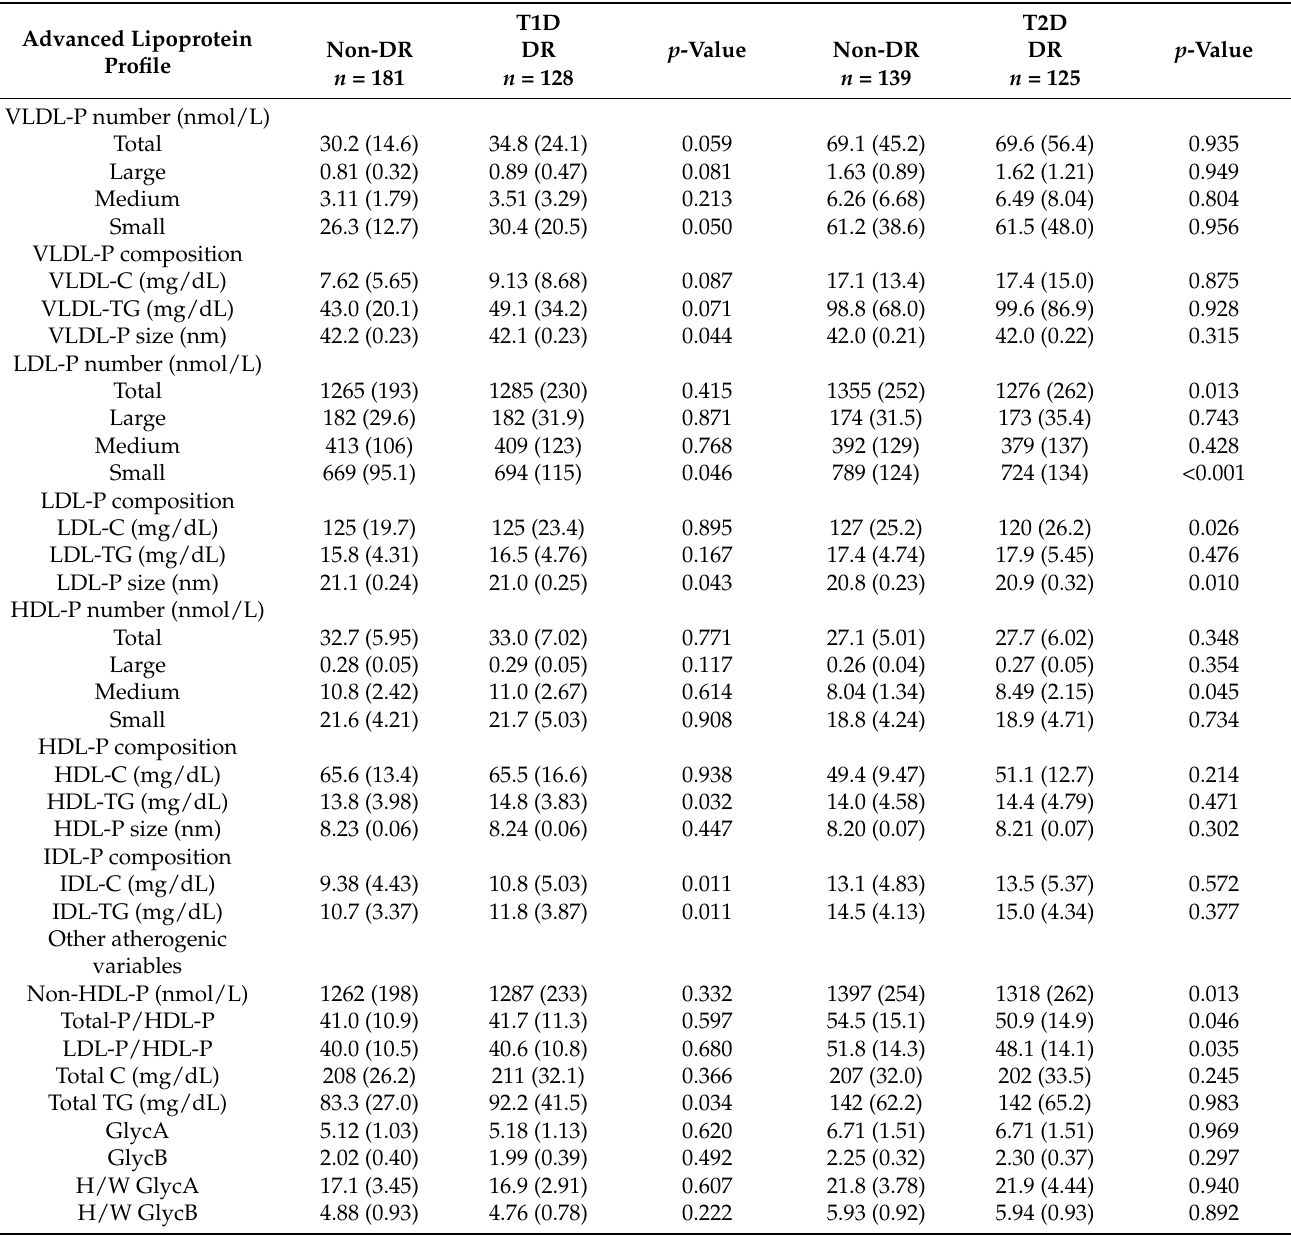
Table 2. Advanced lipoprotein profile according to diabetes type and presence or absence of diabetic